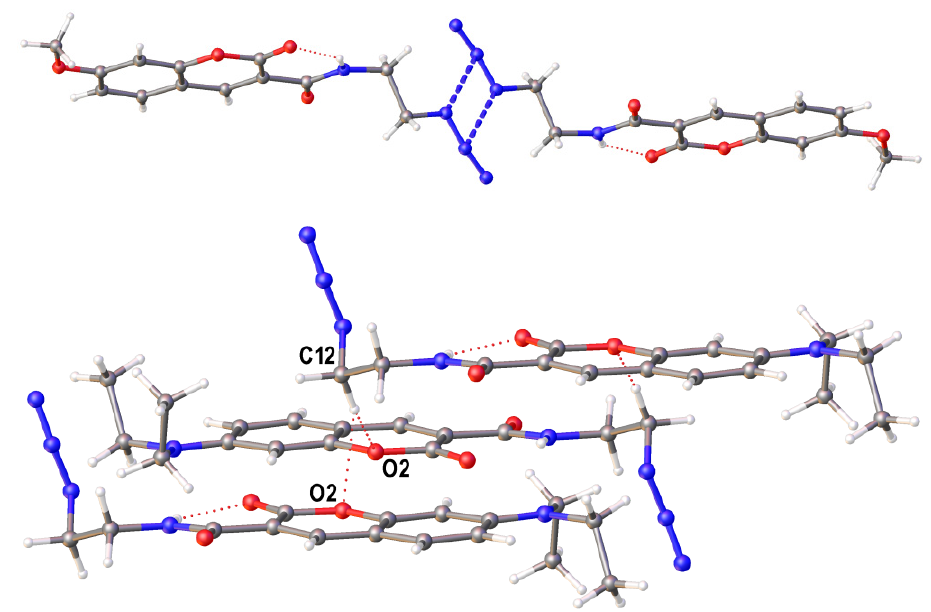
Figure 3. Fragments of crystal packing of 2a ( top ) and 2b ( bottom ) demonstrating the N 3 . . . N 3 stacking interactions in 2a (dashed bold lines) and bifurcate C12(H) . . . O2 H-bond in 2b (dotted lines).